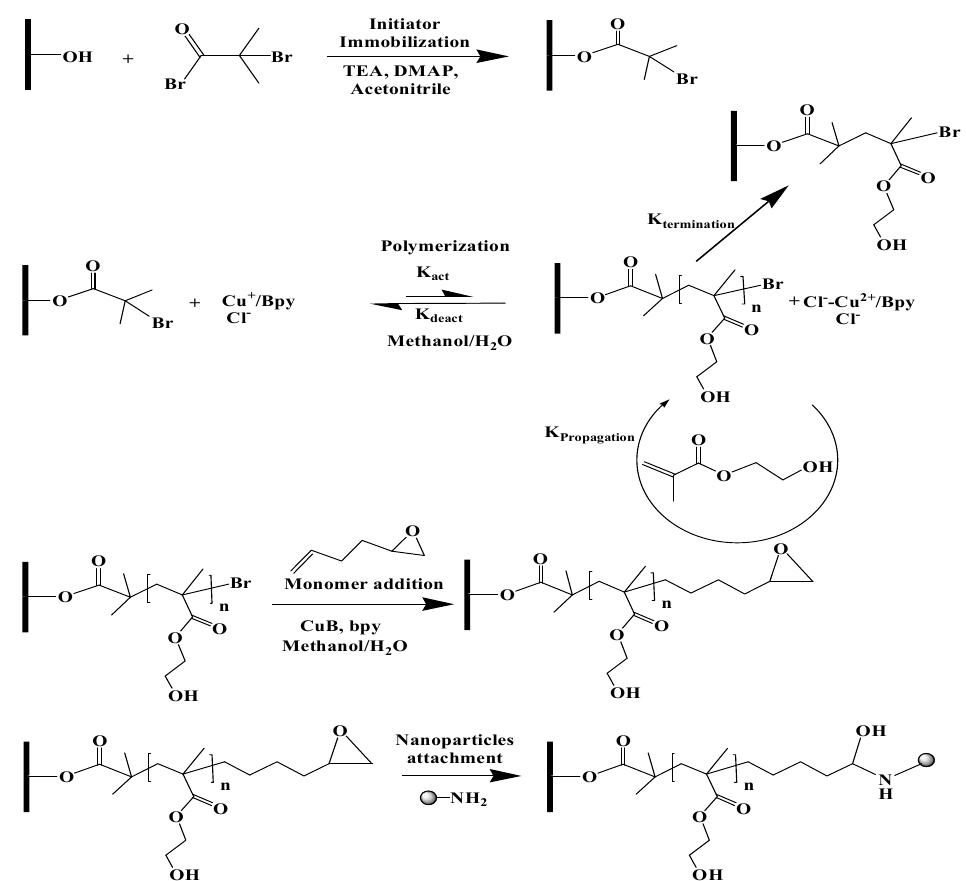
Figure 1. Membrane modification scheme: increasing the time for the initiator immobilization leads to a higher initiator and, thus, grafting density; increasing the polymerization time leads to longer grafted polymer chains [19].